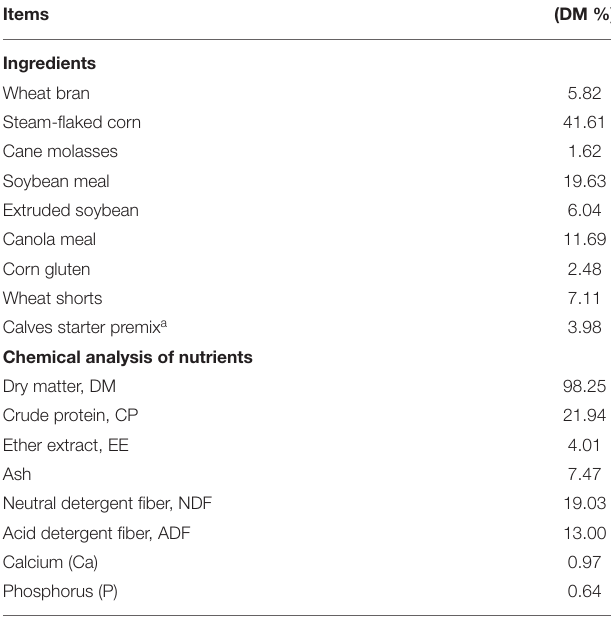
TABLE 1 | Ingredients and chemical composition of pellet starter fed to Holstein heifer calves during the suckling period from birth to 60 days after calving.